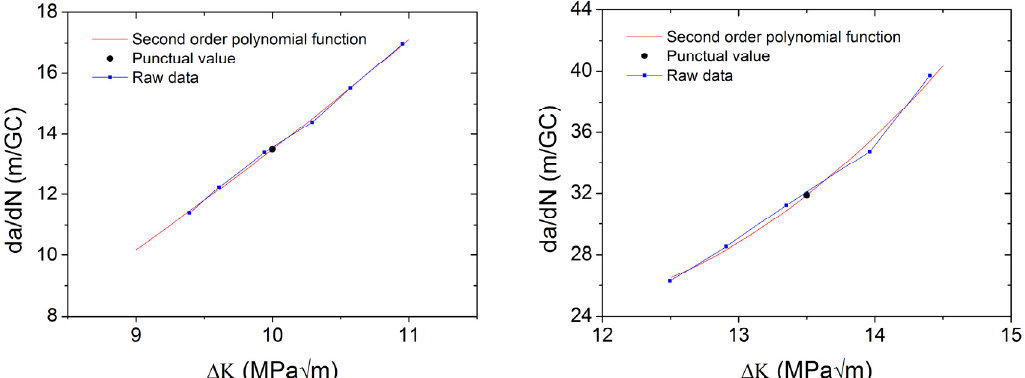
Figure 8: Second order polynomial fit of the crack growth